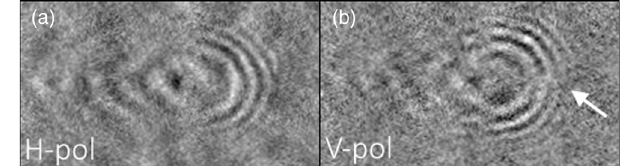
FIG. 4. H-pol (a) and V-pol (b) shadowgrams recorded with the probe ’ s full spectrum after 1190 μ m propagation of the pump. Both images have been processed for improved contrast. The white arrow indicates the location of the on-axis break in the half- ring